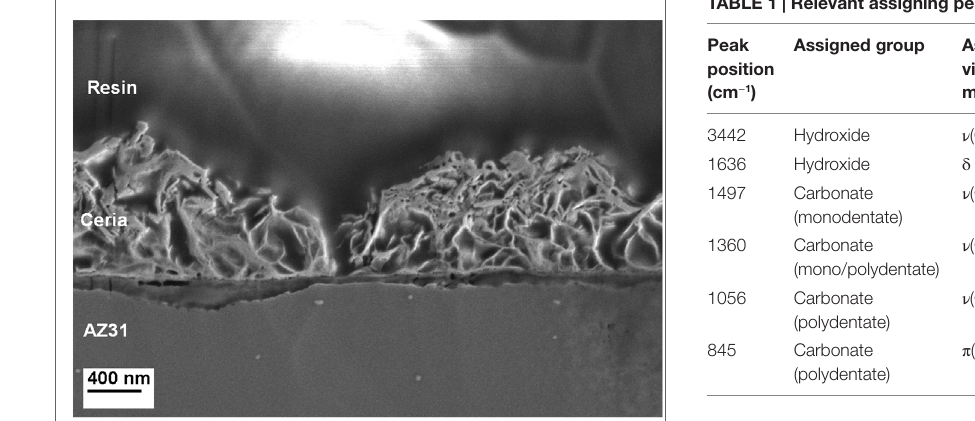
FigUre 3 | cross-sectional analysis of a ce-oxide coated sample illustrating the morphology of the coating and the size of a crack